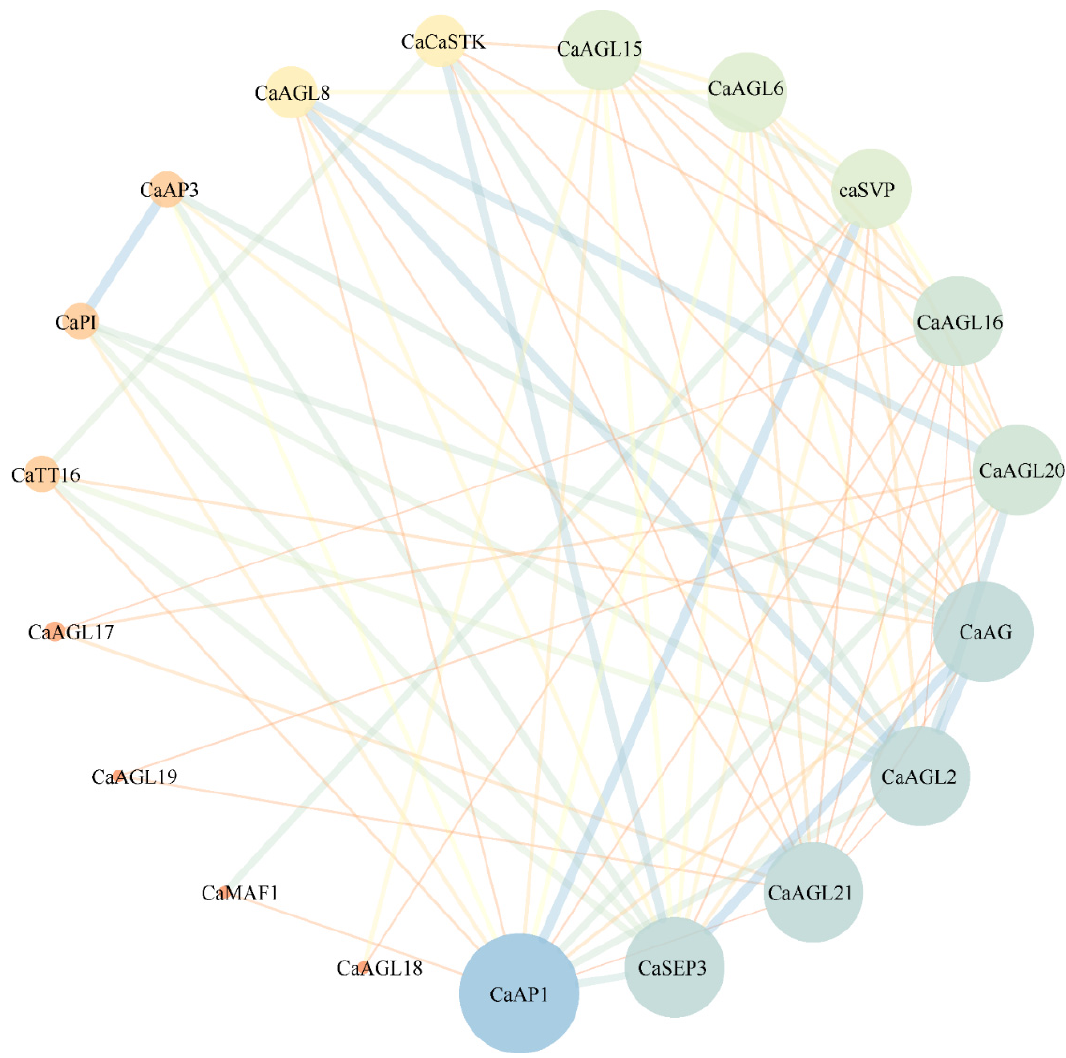
Figure 7. Type II CaMADS-box Protein Interaction Network Diagram. Connection between nodes varies with the combined_score value (representing the reliability of the predicted interaction between the two proteins, ranging between 0 and 1), thickening with an increase in score value. The size of nodes increases with the number of proteins interacting with node proteins.